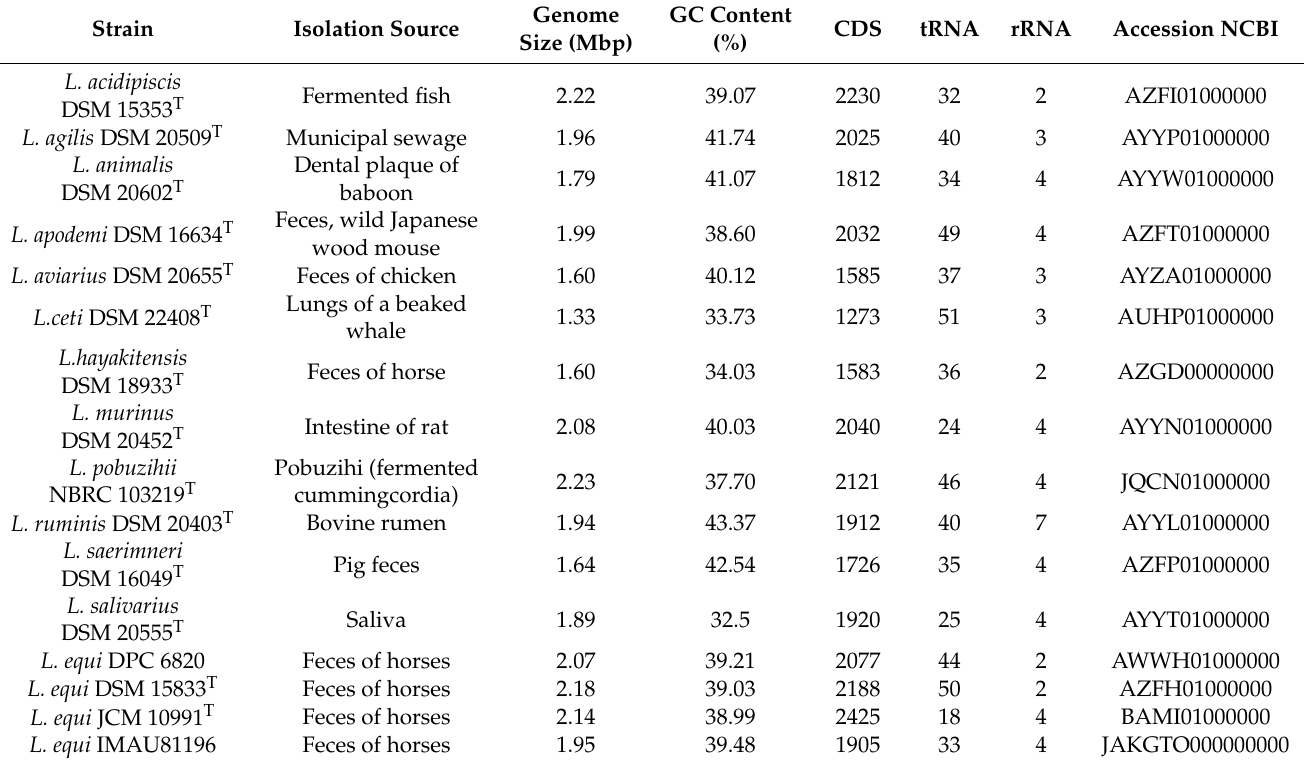
Table 1. Basic genomic characteristics of strains of the genus Ligilactobacillus . Strain